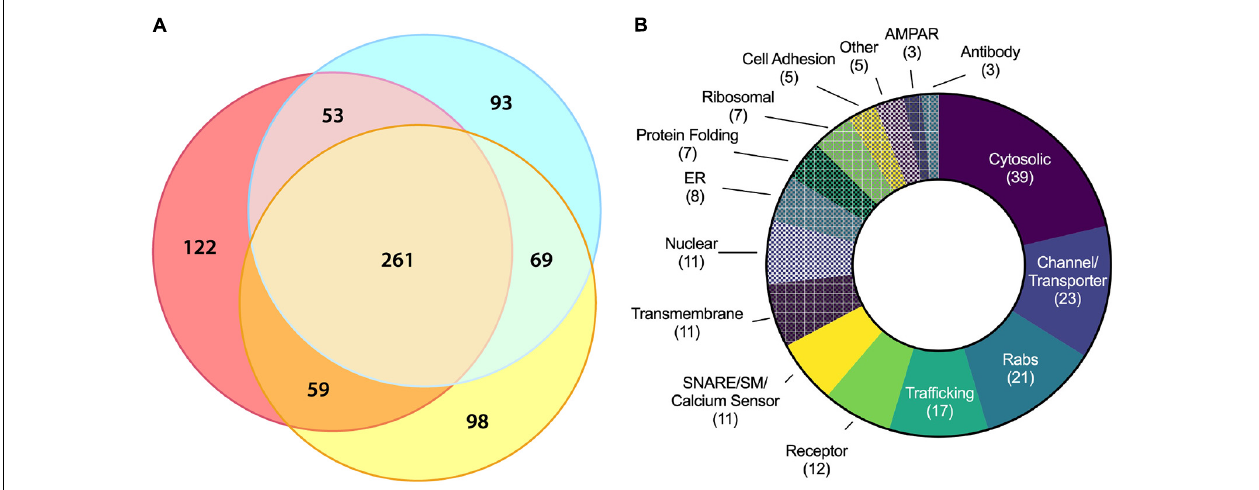
FIGURE 4 | Molecular characterization of ACV proteins using LC–MS/MS. (A) Three-way Venn diagram showing protein hits in three LC–MS/MS biological replicates with each color representing a biological replicate. (B) Protein ontology of the 180 identified candidates using gene ontology resource. See Table 1 for all